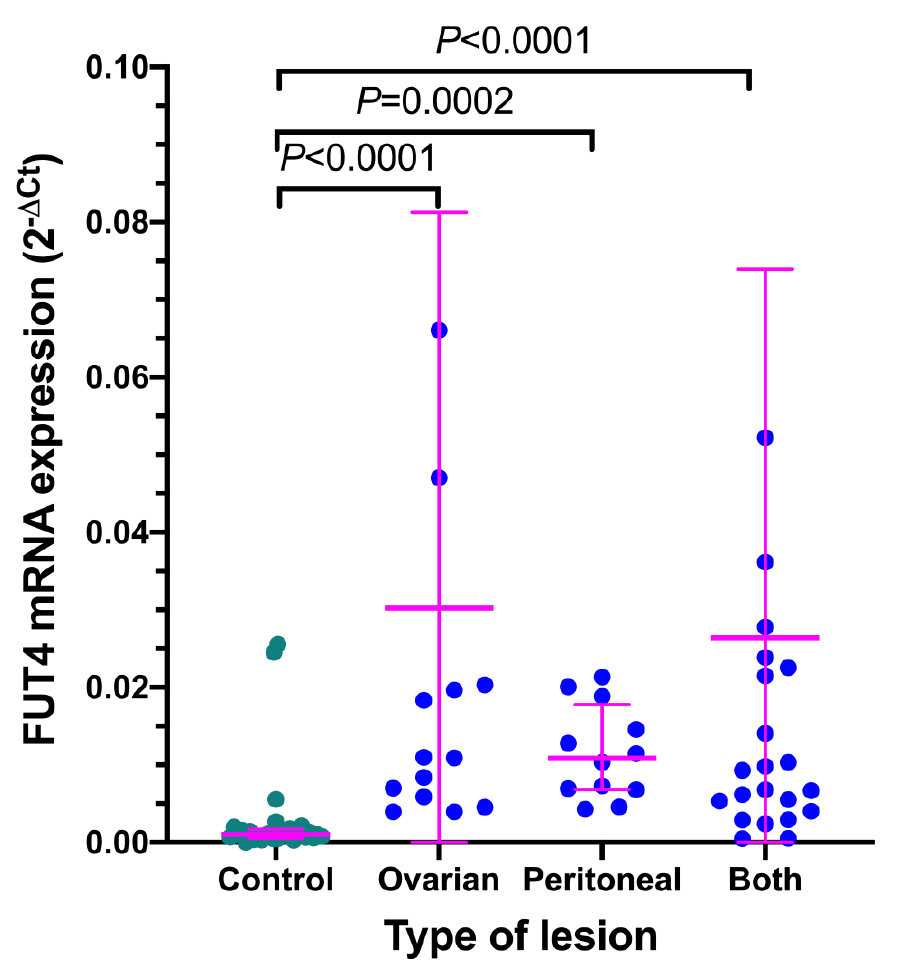
Figure 3. Expression of FUT4 mRNA in the eutopic endometrium from women with endometri- osis in relation to the localization of ectopic endometriotic lesions. FUT4 mRNA levels were com- pared in patients with different lesion locations. The normal endometrium from control women served as a control. All data are shown as scatterplots with median and interquartile ranges. Samples from the endometriosis group displaying relative expression values over 0.08 ( n = 3) are not included in the graph. Statistical differences between groups were computed by the Kruskal–Wallis test and Dunn’s post hoc test.